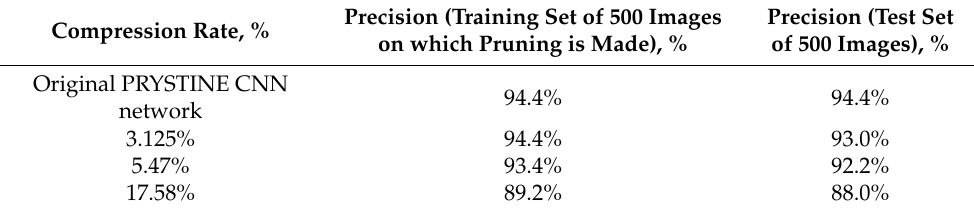
Table 1. Experimental results of compressing the CNN PRYSTINE 4th layer. Precision (Training Set of 500 Images on Precision (Test Set of Compression Rate, % which Pruning is Made), % 500 Images), %